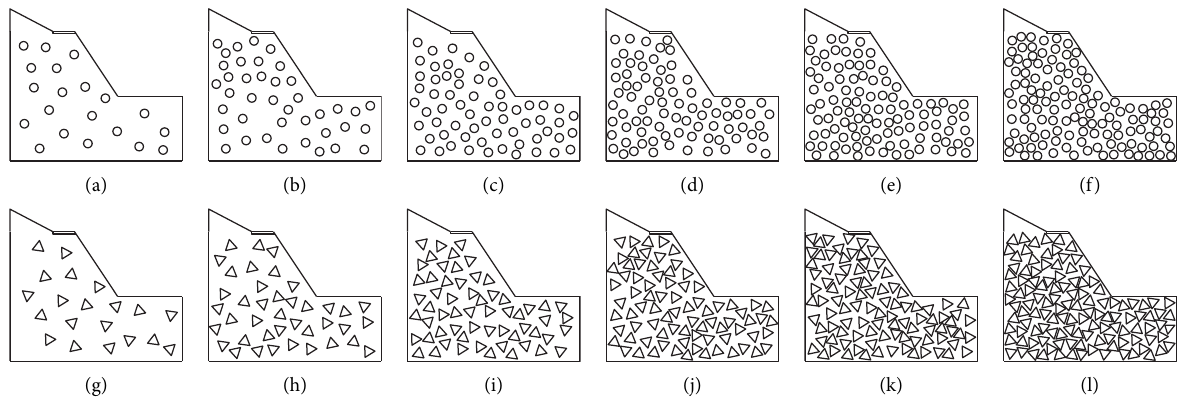
Figure 10: Typical models in one group. (a) 10% round rock. (b) 20% round rock. (c) 30% round rock. (d) 40% round rock. (e) 50% round rock. (f) 60% round rock. (g) 10% angular rock. (h) 20% angular rock. (i) 30% angular rock. (j) 40% angular rock. (k) 50% angular rock. (l) 60% angular rock.